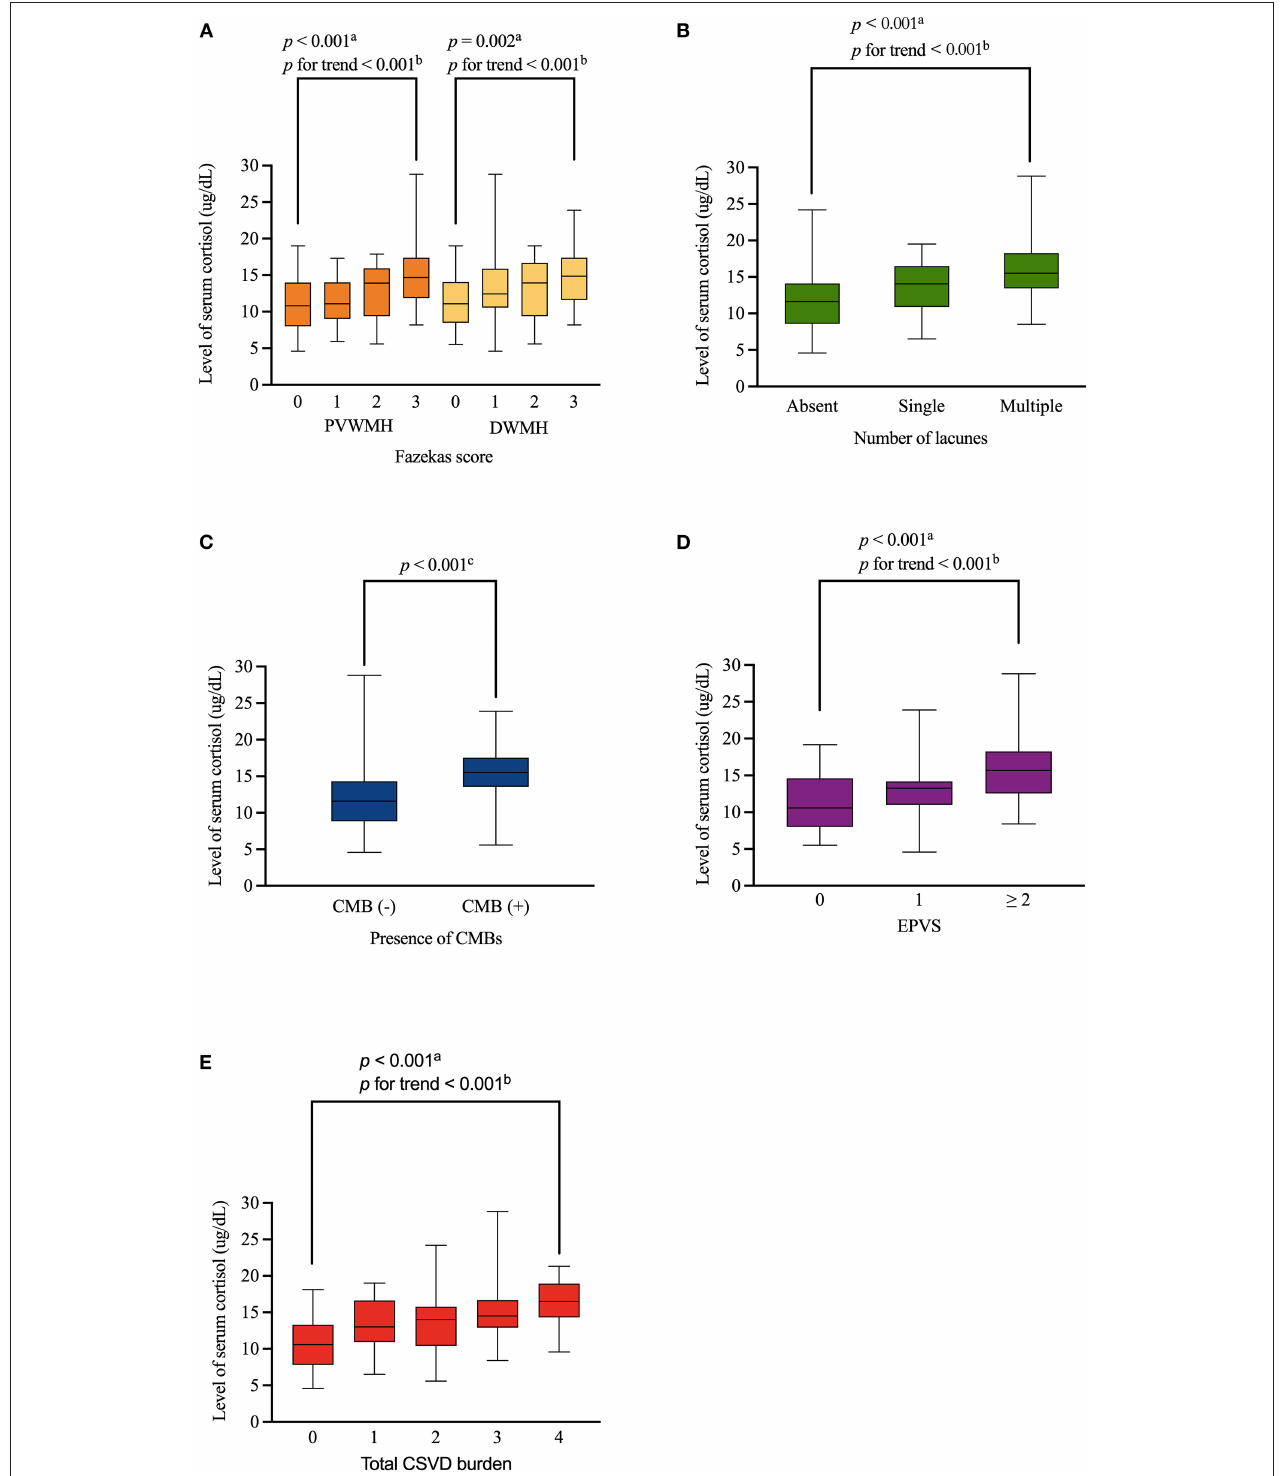
FIGURE 2 | Distribution of levels of serum cortisol according to WMH, lacunes, CMBs, EPVS and total CSVD burden. Serum cortisol level was positively associated with Fazekas score (both of PVWMH and DWMH), numbers of lacunes, presence of CMBs, moderate-severe EPVS, and total CSVD burden in a dose-dependent manner ( A–E , respectively). Boxplot elements: center line represents the median, box bounds represent the 25th and 75th percentile, and whiskers represent minimum and maximum respectively. PVWMH, periventricular white matter hyperintensity; DWMH, deep white matter hyperintensity; CMBs, cerebral microbleeds; EPVS, enlarged perivascular spaces. a Kruskal-Wallis test. b Jonckheere-Terpstra test. c Mann-Whitney U test.